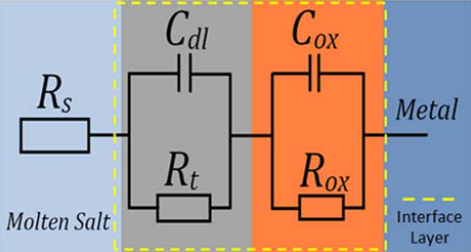
Figure 13. Equivalent circuit representing the corrosion of metals forming a protective scale in molten salts. molten